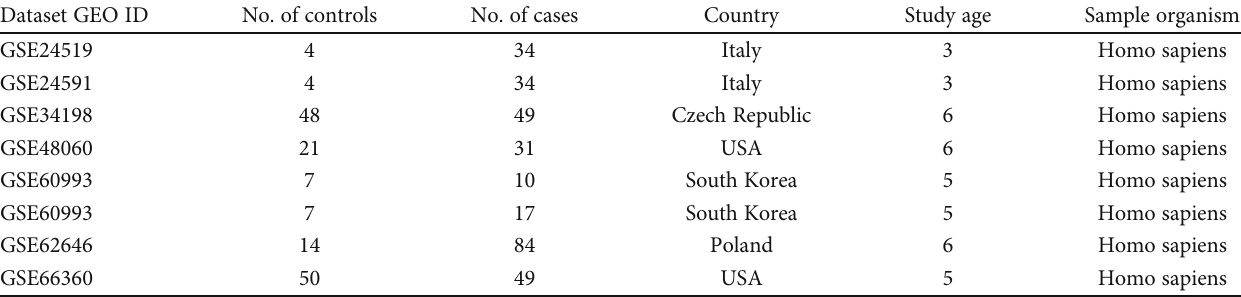
Table 1: The eight MI expression datasets selected for mega-analysis.